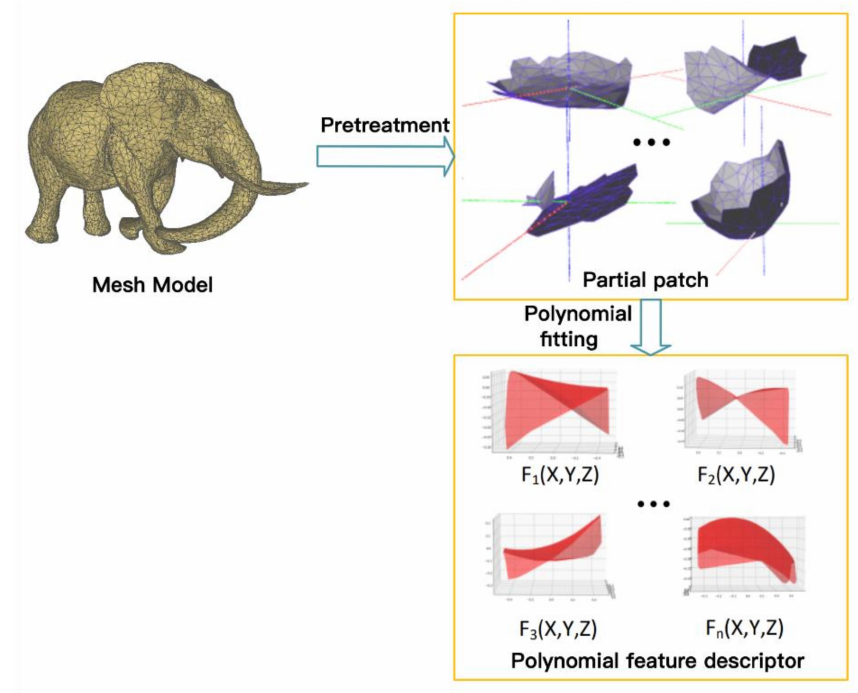
Figure 5. Polynomial feature extraction of mesh